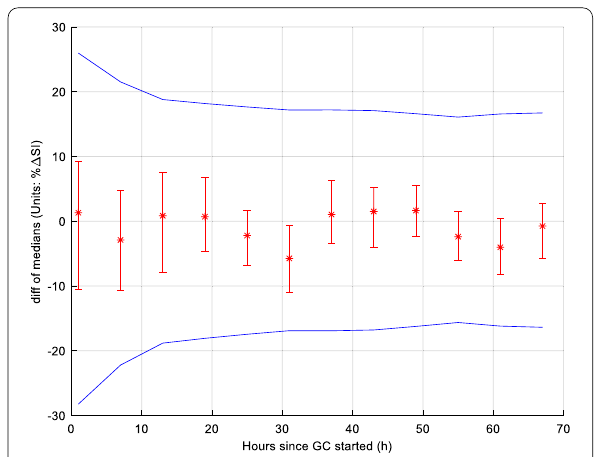
Fig. 7 Equivalence testing on insulin sensitivity variability (%ΔSI) for each 6 h block. The blue lines give equivalence range for typical 9.4% BG measurement error. The 95% CI (bars) bootstrap intervals never cross, and are always within, the equivalence range limits, indicating these 6-hourly blocks are